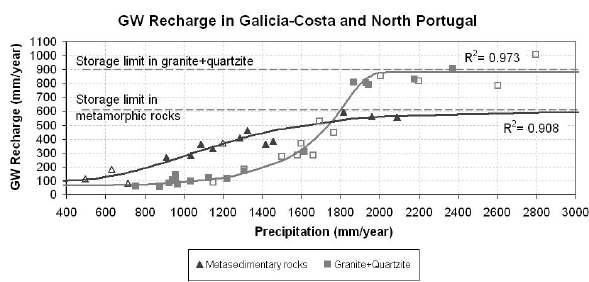
Fig. 5. Relationship between groundwater recharge and precipita- tion, depending on the geology. Filled symbols correspond with data gathered in Galicia-Costa area; other data were gathered from catchments in the nearby Northern